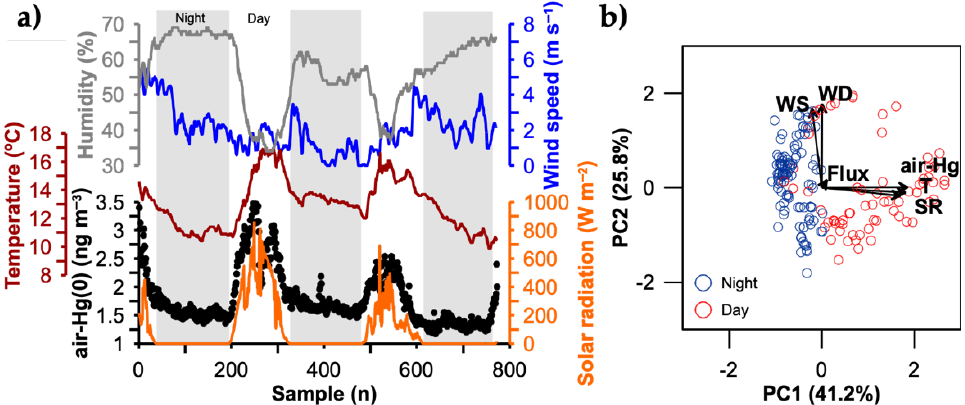
Figure 5. ( a ) Diurnal variation of air Hg(0) concentrations (ng m −3 ) with the meteorological parameters and ( b ) principal component analysis of data obtained during the day (red circles) and night (blue circles) in the background site ALC. Air temperature—T (°C), total incoming solar radiation—SR (W m −2 ), wind speed—WS (m s −1 ), wind direction—WD (°), measured air Hg(0) concentrations — air-Hg (ng m −3 ) and Hg(0) flux—Flux (ng m −2 h −1 ); the grey shadow areas correspond to the night period.